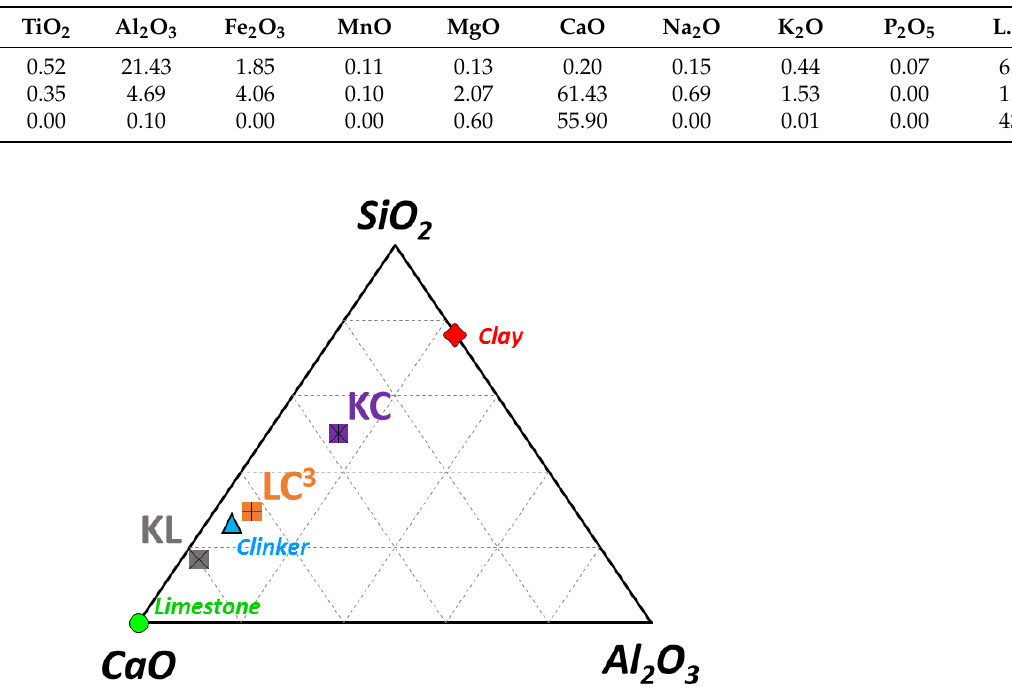
Table 1. Chemical composition of raw materials (wt %).